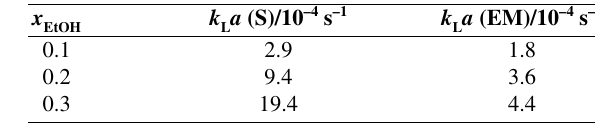
Table 3: Comparisons between the k rogeneity stages, calculated for both the simple (S) 10 and extended (EM) kinetic models at the temperature, ϑ = 30 °C.